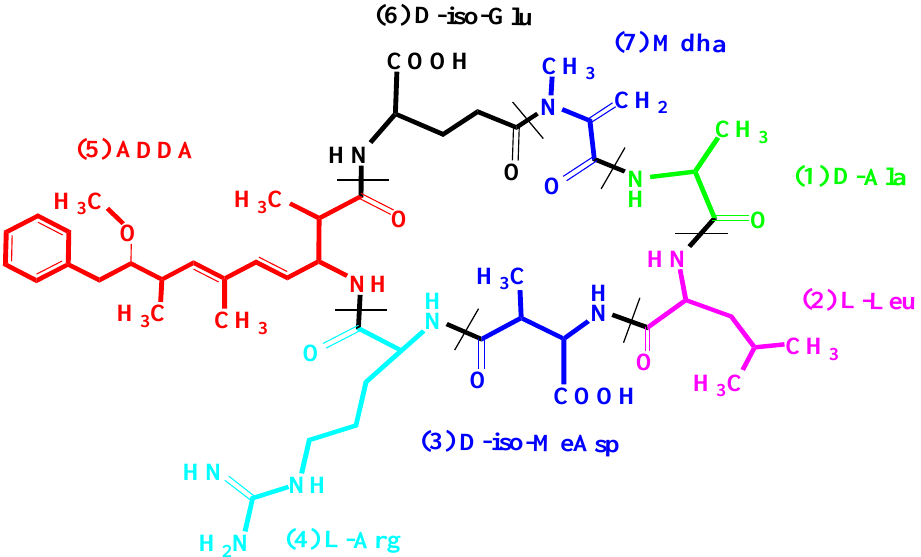
Figure 1. Structural formula of MCY-LR and color coding of amino acids [17].